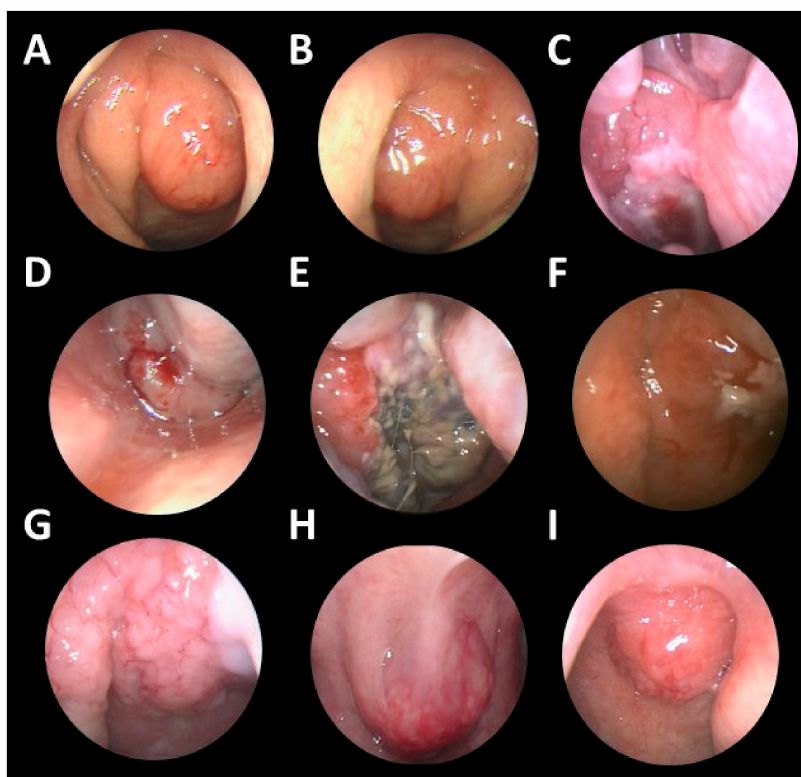
Figure 3. Endoscopic views of various NP lymphomas. Endoscopic examinations showed various NP lymphomas, which were heterogeneous, from smooth bulging masses to hemorrhagic masses, and some tumors showed necrosis over their surface: ( A , B ) small lymphocytic lymphoma, ( C , D , E ) DLBCL, ( F ) NKTCL, ( G , H ) mantle cell lymphoma, ( I ) MALToma.